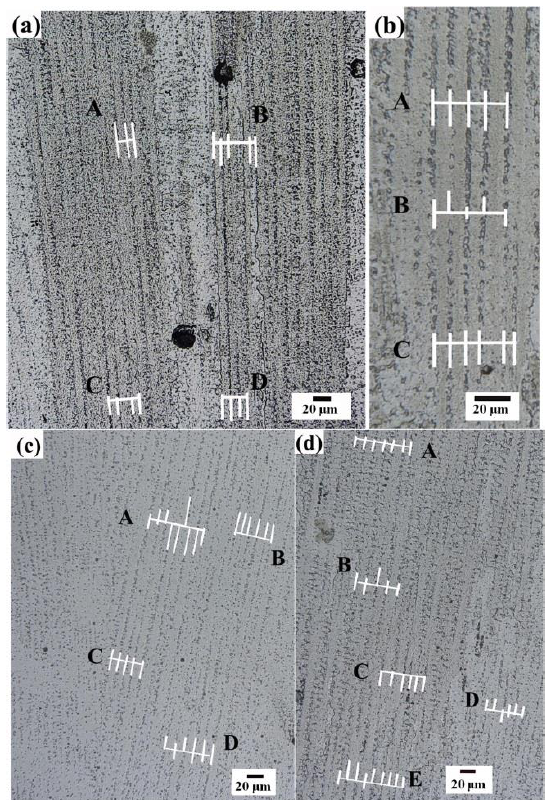
Figure 19. Primary dendrite arm spacing under ( a ) reducing power water cooling (7.5 L/min) condition, ( b ) reducing power air cooling condition, ( c ) reducing power water cooling (4 L/min) condition, ( d ) constant power air cooling condition.